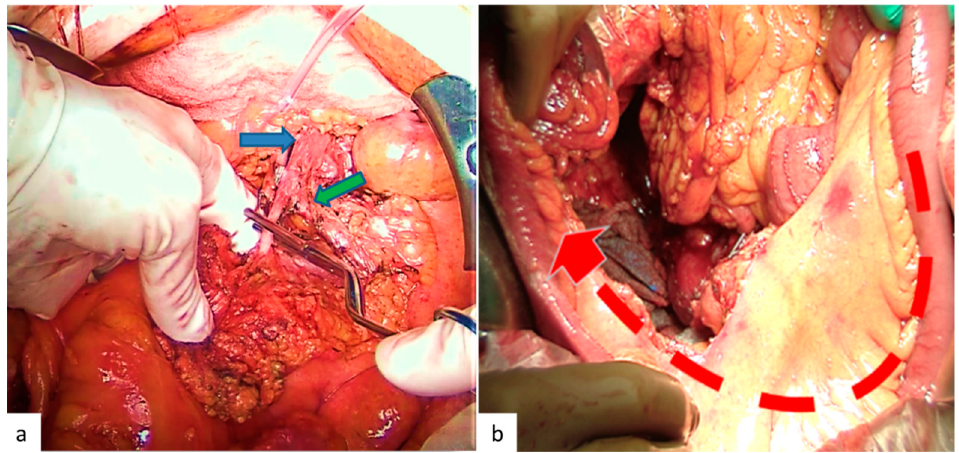
Figure 4. Operative view during the lymphadenectomy. ( a ) Clamping test after the dissection of the mesenteric superior artery and before the resection of the small bowel to visualize the remnant vascularized bowel. The blue arrow shows the mesenteric superior artery, and the green arrow shows the firsts jejunal arteries. ( b ) Small bowel vascularized by the remnant jejunal arteries. Table 1. Rate of MLNM in SI-NET.